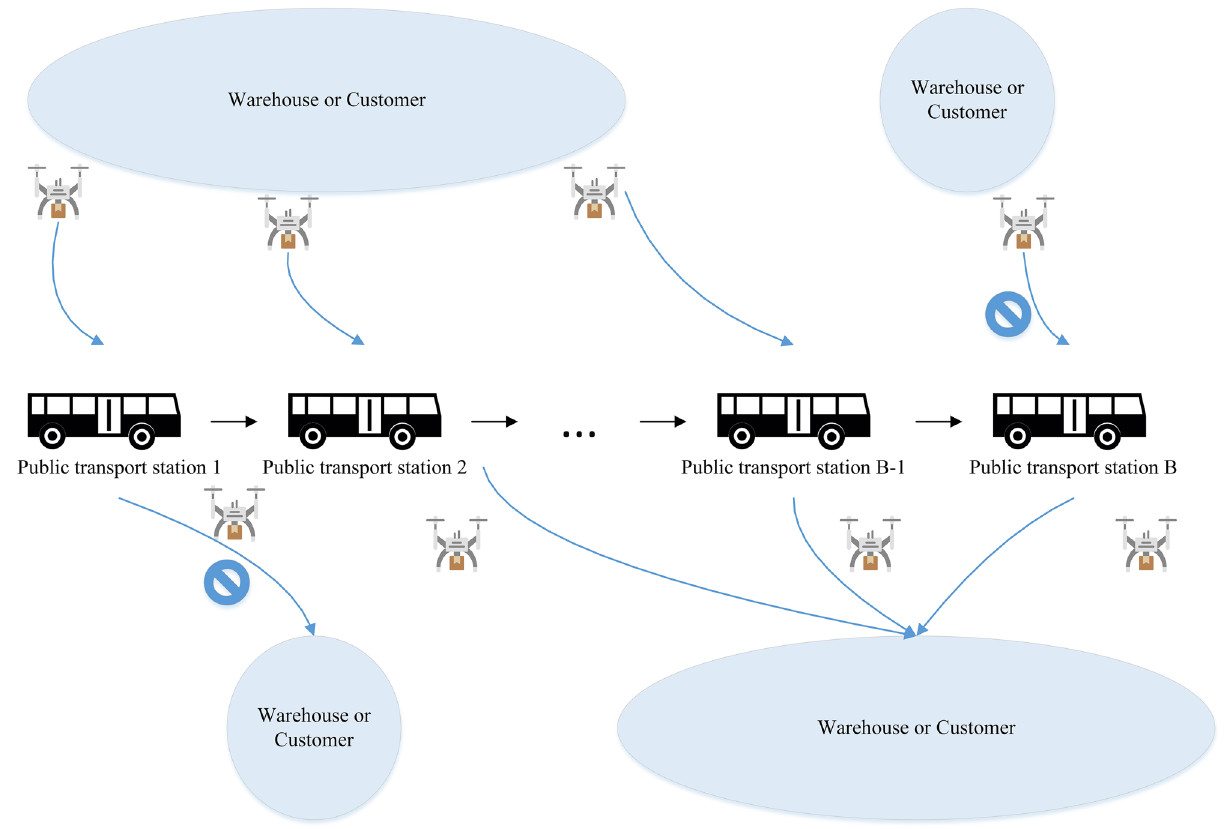
Figure 2. Merging procedure at public transport